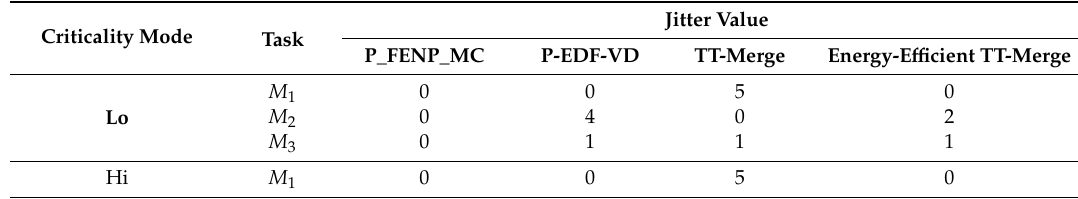
Criticality Mode.